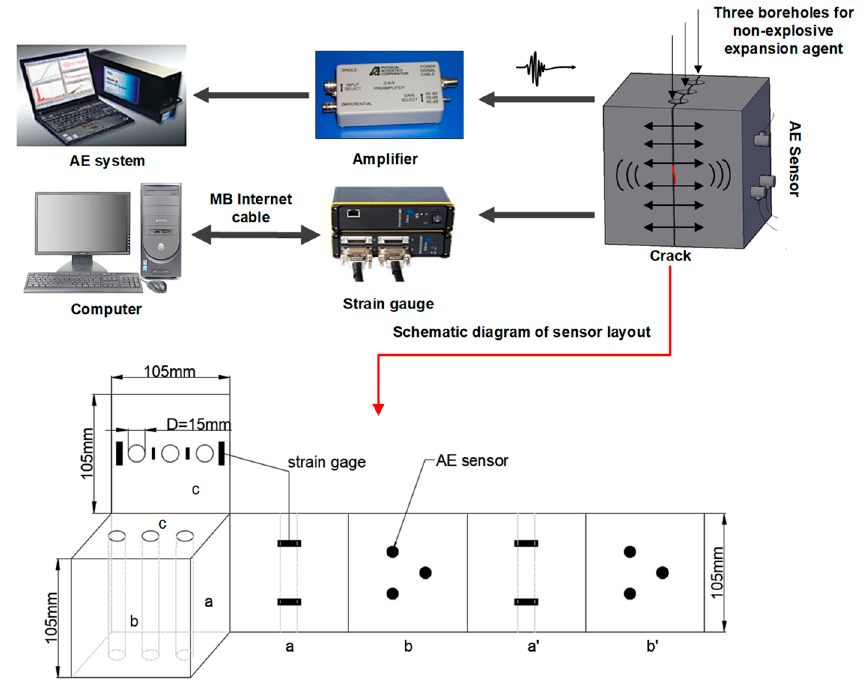
Figure 7. Schematic of non-explosive fracturing agent expansion rock AE test. Non-explosive fracture agent was injected into three boreholes of the specimen, and the fracture surface was formed in the center of the three boreholes. The label of specimen surface a’ is parallel to a, and b’ is parallel to b [25]. Table 3. b values of 6 channels of red sandstone, marble, granite, and limestone.